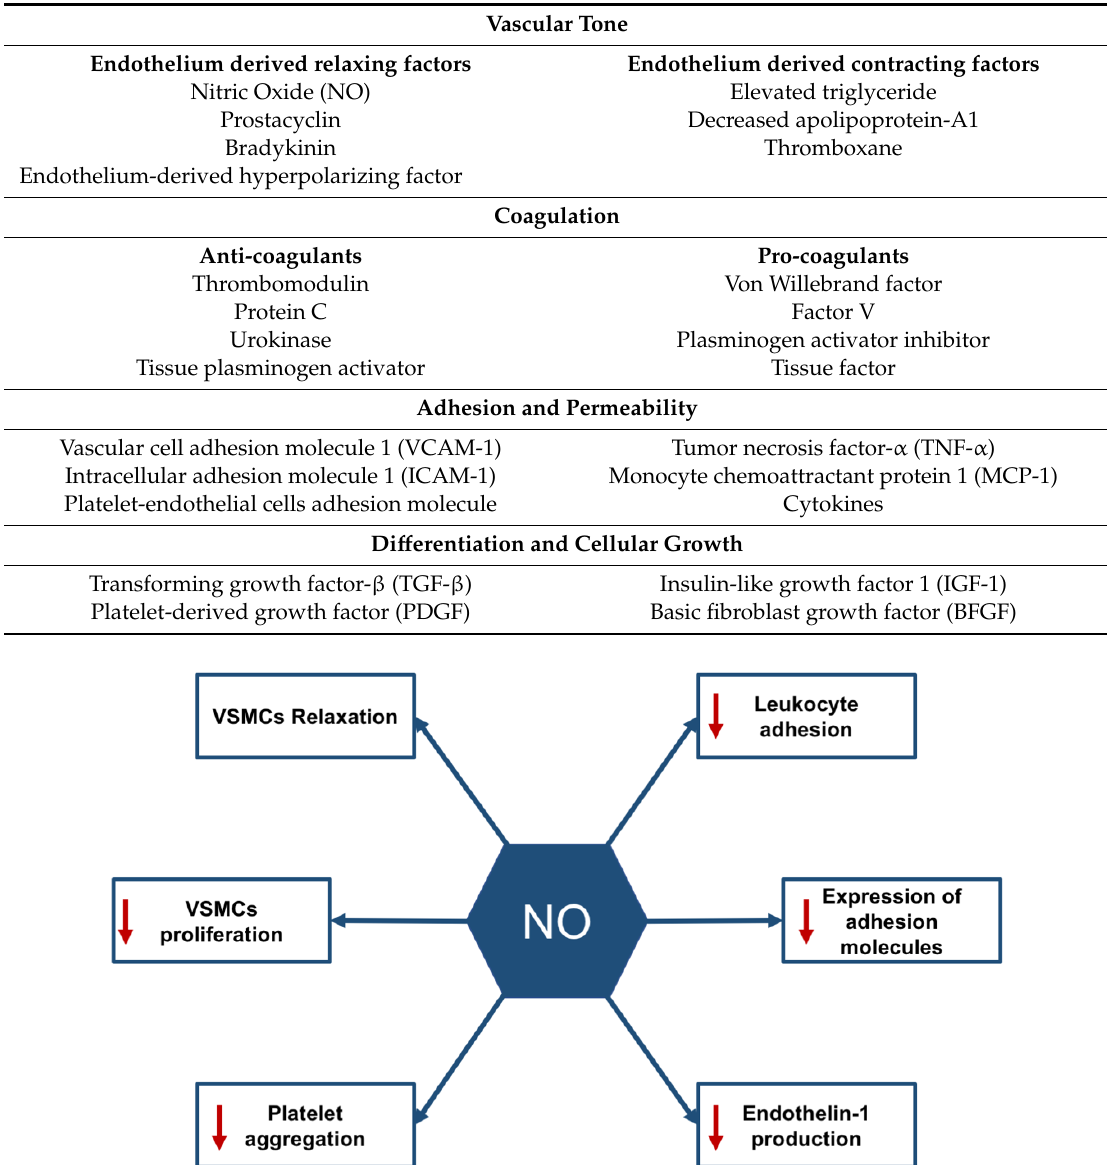
Table 2. Major factors released by endothelial